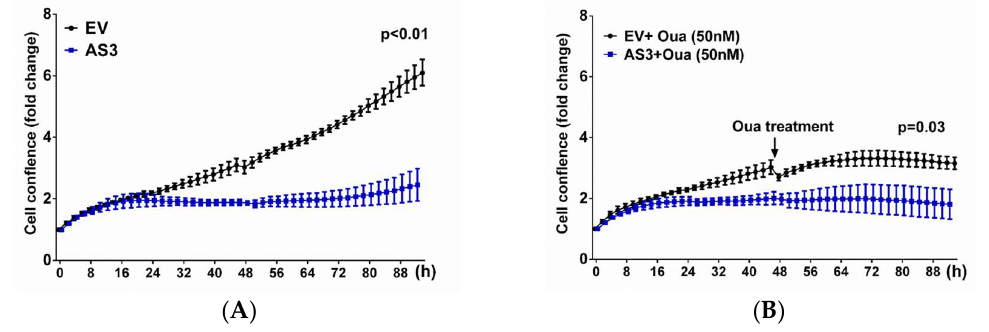
Figure 8. Overexpression of ATP1A1-AS1-203 inhibits HK2 cell growth in presence or absence of ouabain. HK2 cells were transfected with ATP1A1-AS1-203 vector (AS3) or empty vector (EV) for 48 h, followed by treatment of 50 nM ouabain (Oua) for another 48 h. Cells without ouabain treatment was used as control. Cell proliferation was monitored using an Incucyte incubator equipped with a camera that automatically taking pictures every 2 h at 9 different regions of each cell culture well. ( A ) Cell growth curve in AS3 or EV transfected HK2 cells without ouabain treatment; ( B ) Cell growth curve in AS3 or EV transfected HK2 cells that treated with 50 nM ouabain. These experiments were repeated four times. Data was analyzed using Two-way ANOVA.